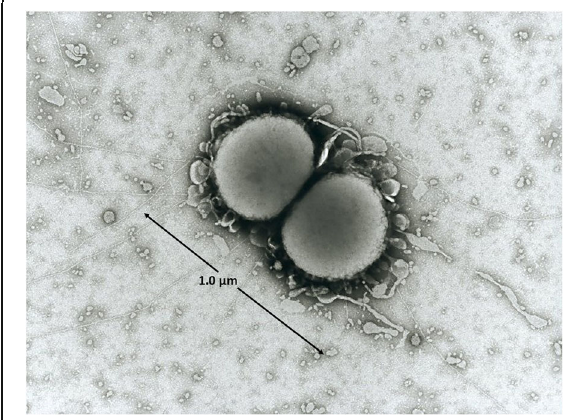
Fig. 1 Photomicrograph of N. lactamica Y92 – 1009. This image was obtained with transmission electron micrography and displays the diplococcoid nature of the N. lactamica Y92 – 1009 cell. The size of the cell is indicated in micrometres ( μ m)